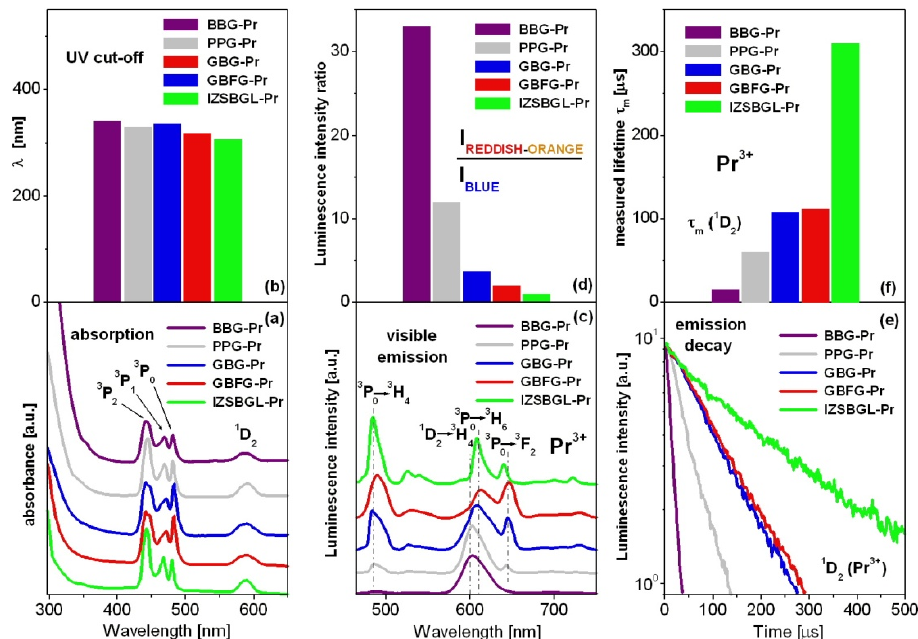
Figure 3. Absorption ( a , b ) and visible emission ( c , d ) spectra and emission decay curves ( e , f ) for Pr 3+ ions in inorganic glasses.